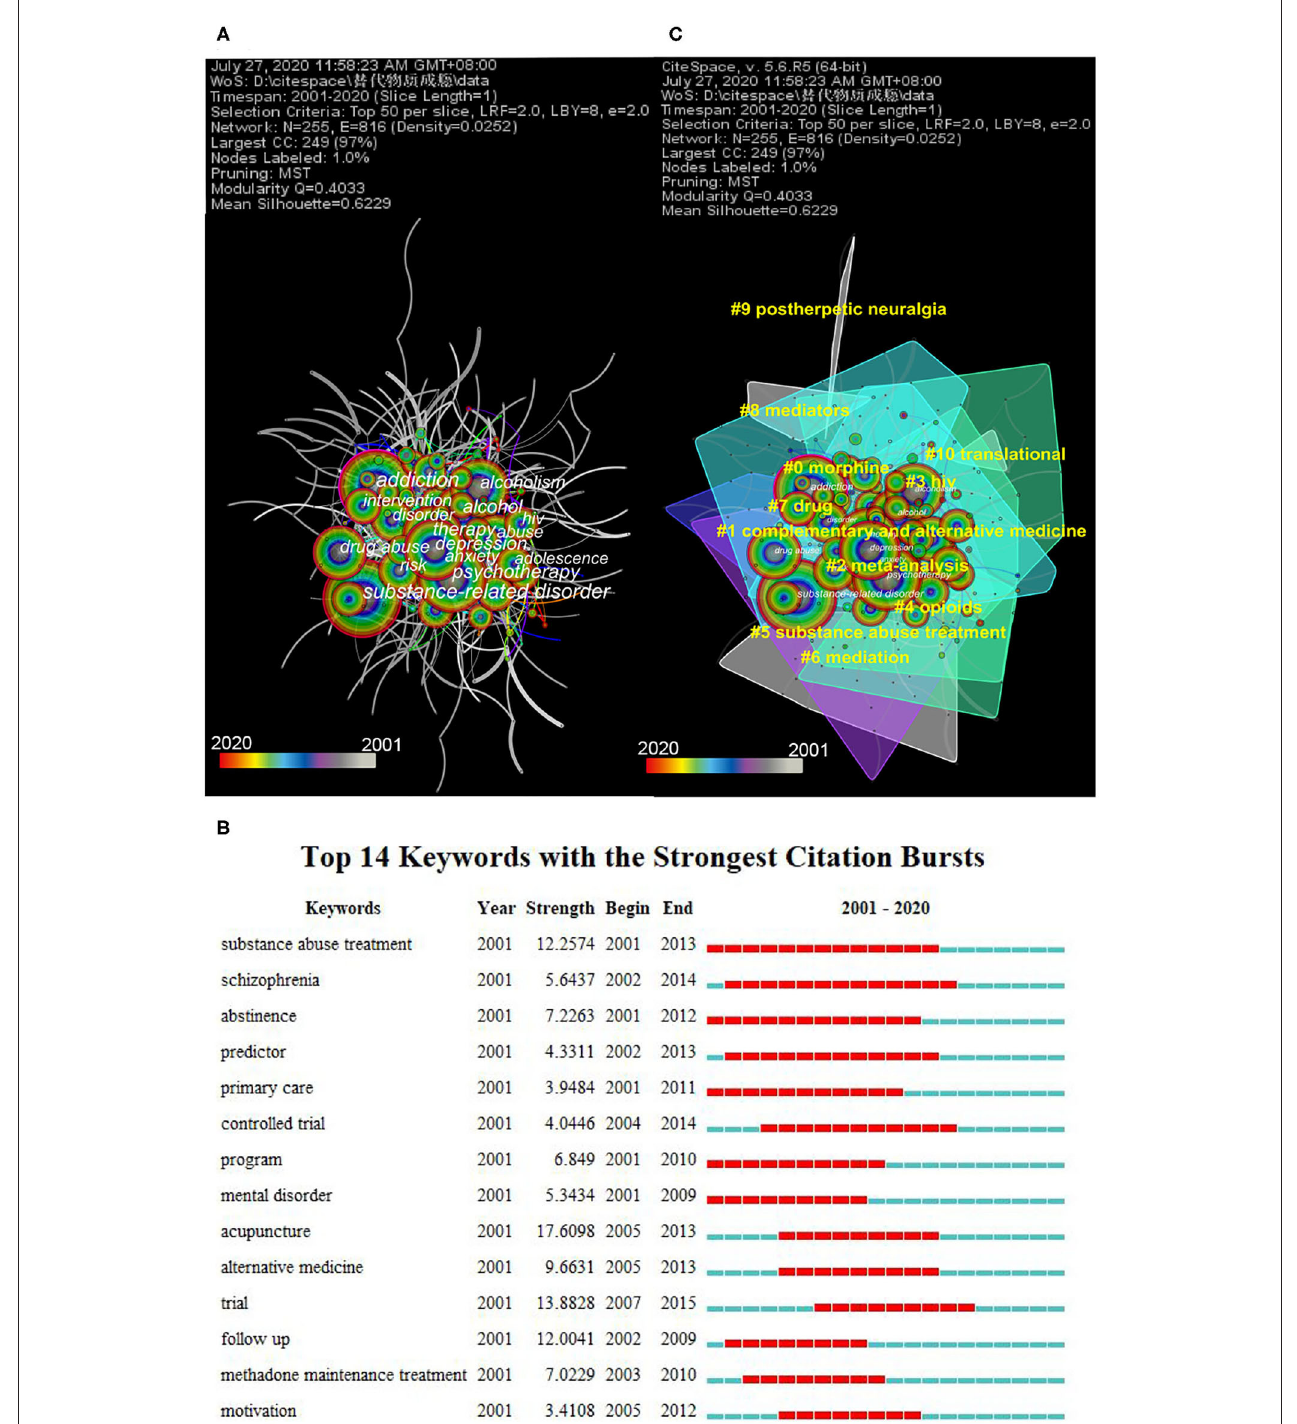
FIGURE 5 | Visualization of complementary and alternative medicine (CAM) for substance use disorders (SUDs) by keyword. (A) The network map of keywords (top 15 results); 255 keywords were included, with 255 nodes and 816 links. (B) Top 14 keywords with the strongest citation bursts. Each bar presents each year from 2001 to 2020. The red bar indicates that the institution had frequent citation bursts, and the blue bar indicates that the institution had infrequent citation bursts. (C) The co-occurrence network map of the cluster by keywords for CAM for SUDs. A total of 16 clusters were found, with a modularity Q of 0.4033 and a mean silhouette of 0.6229. Time slice on 1 year, and different colors present different years as the legend shows. The nodes consist of an annual ring by different colors as the legend, and the thickness of the annual ring represents the frequency of keywords at the corresponding time. The area with similar color suggests similar clusters and shows cluster at the corresponding time as